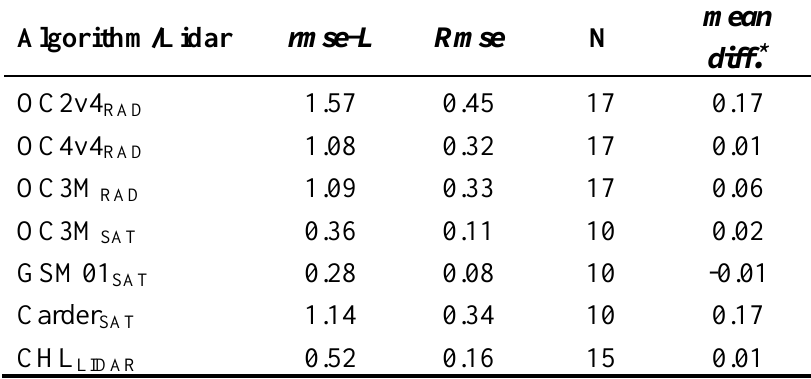
Table 1. Comparison between different in situ and satellite estimates of surface chlorophyll- a concentration in the Brazilian Southeastern continental shelf and slope waters in November 2004. (N= number of observations; RAD= in situ radiometry; SAT= MODIS